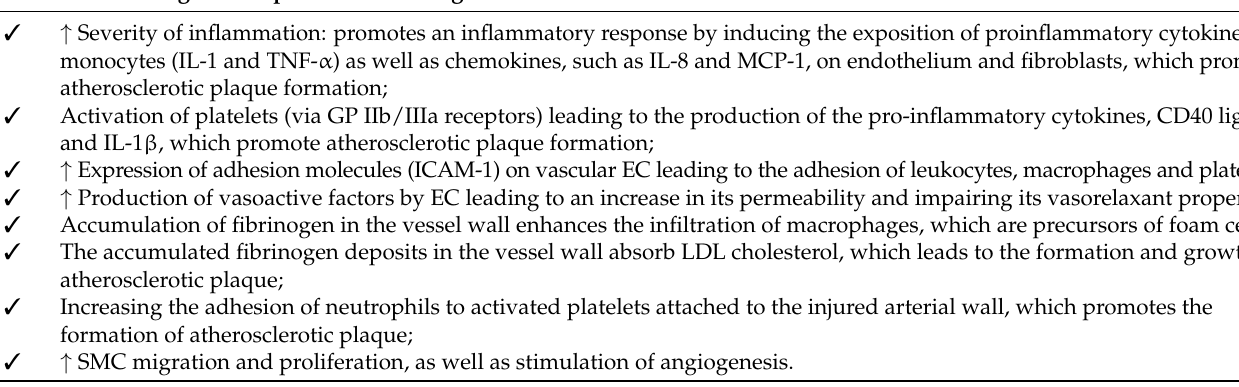
Table 1. The pro-atherogenic mechanisms of action of fibrinogen [20]. IL-1—Interleukin 1;